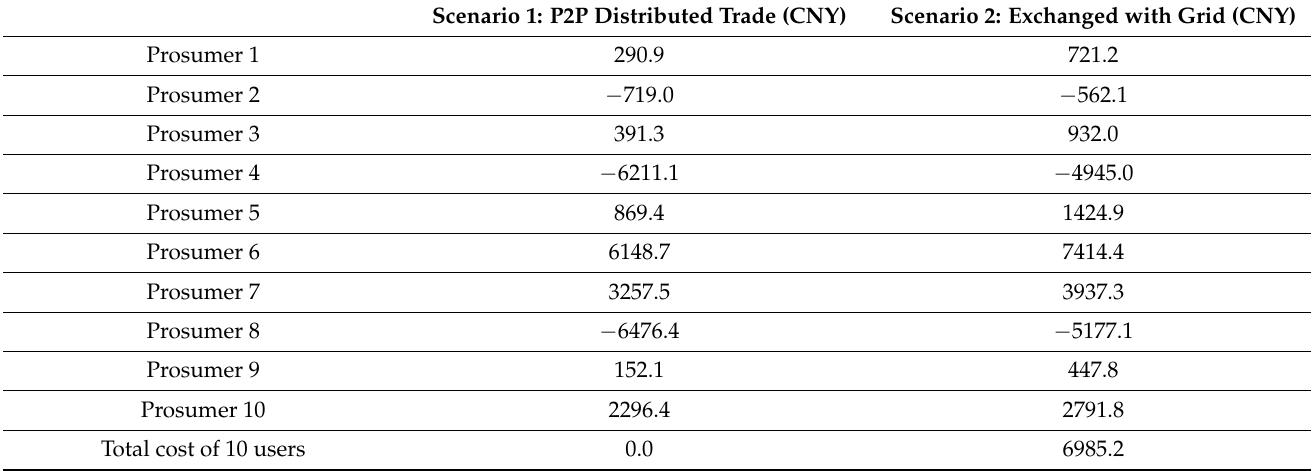
Table 6. The cost comparison of the successfully traded exchange power for 24 h under two scenarios.